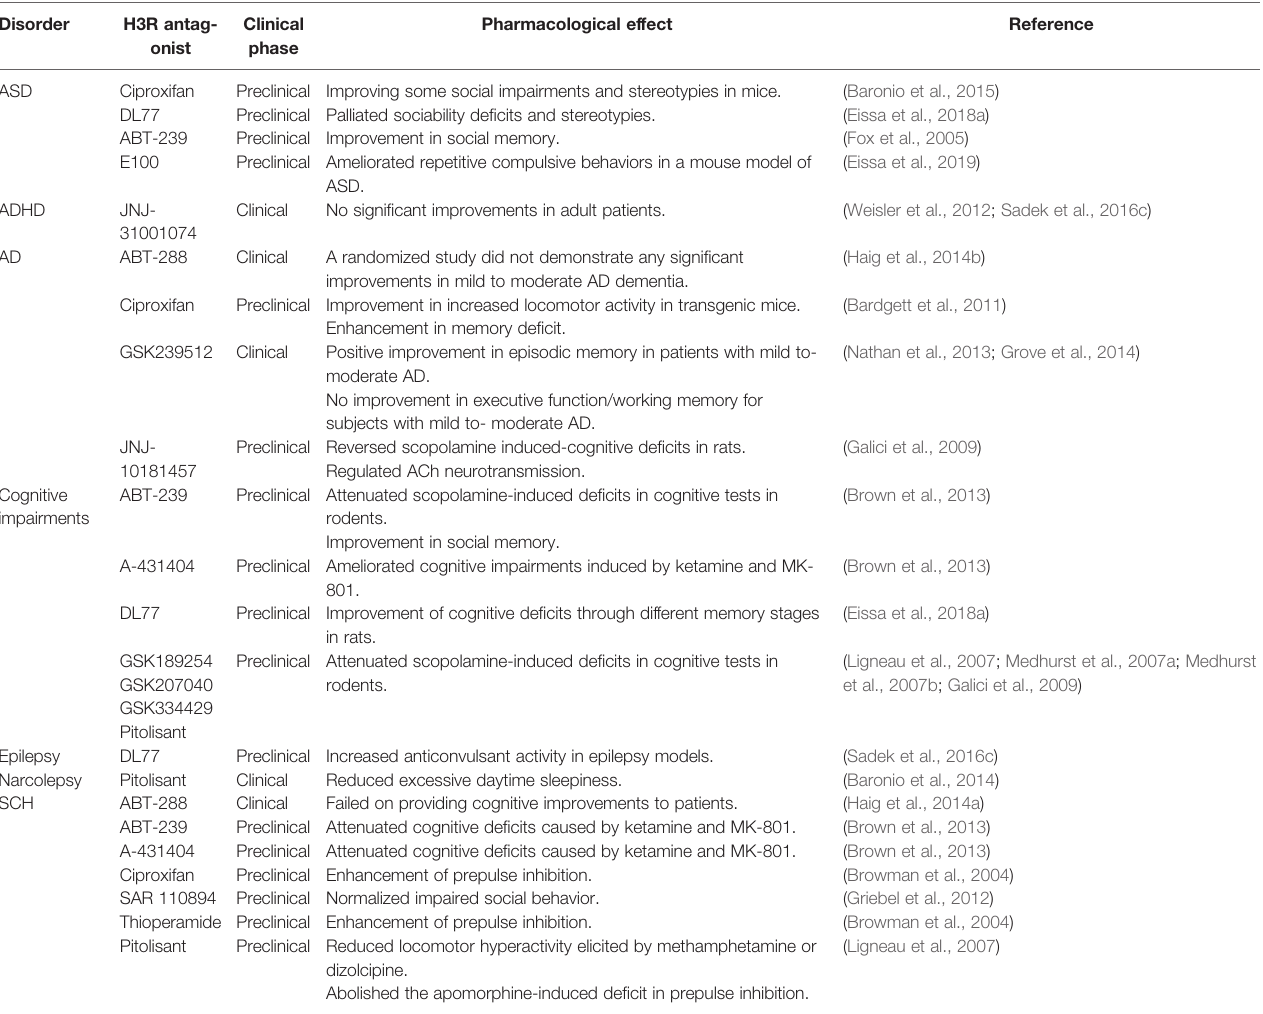
TABLE 2 | Summary of H3R antagonists that have been in clinical and preclinical trials in ASD and related brain disorders.